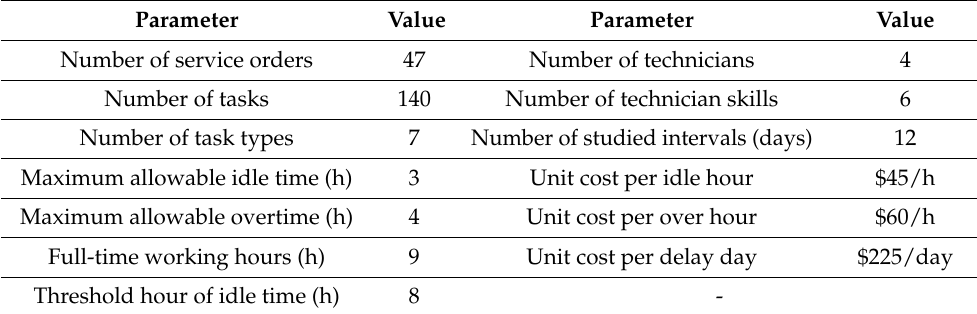
Table 1. Values of the main input